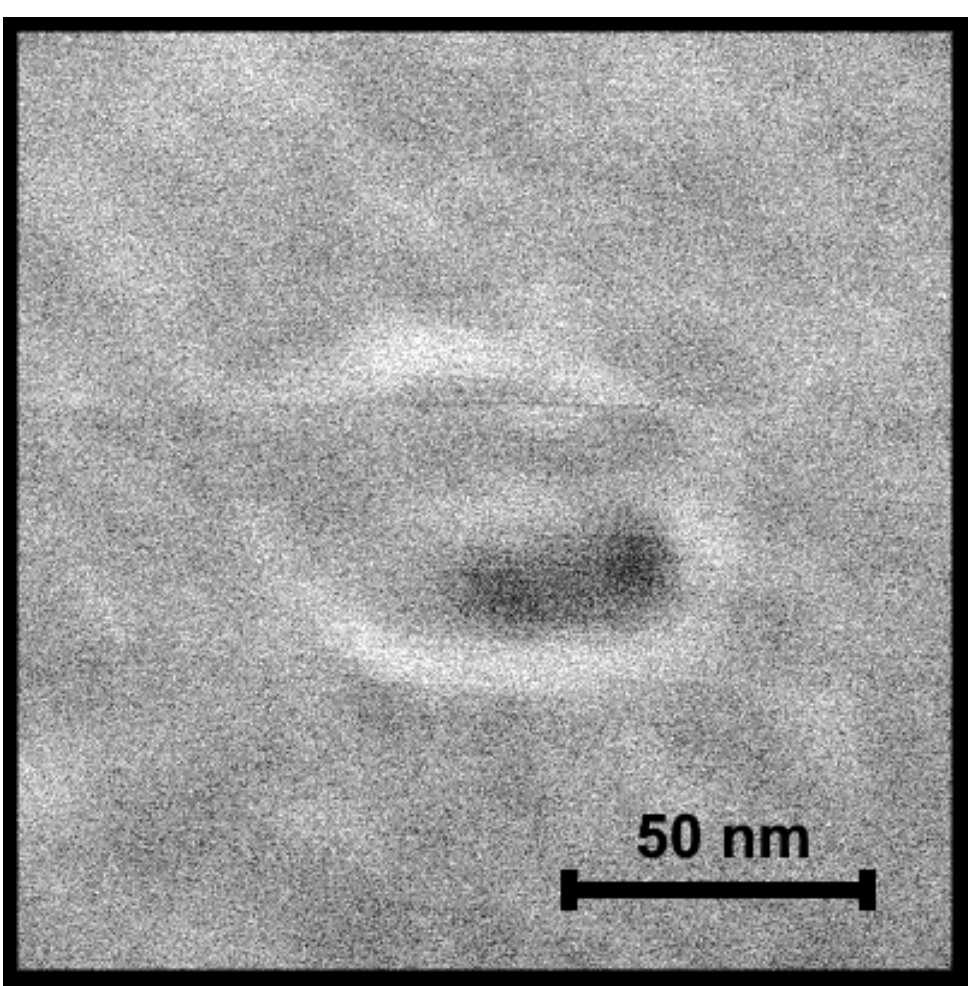
Figure 3. SEM image of a typical nanostructure after the exposure of In droplets obtained after the deposition of 1 ML of indium to the ultra-low arsenic flux.